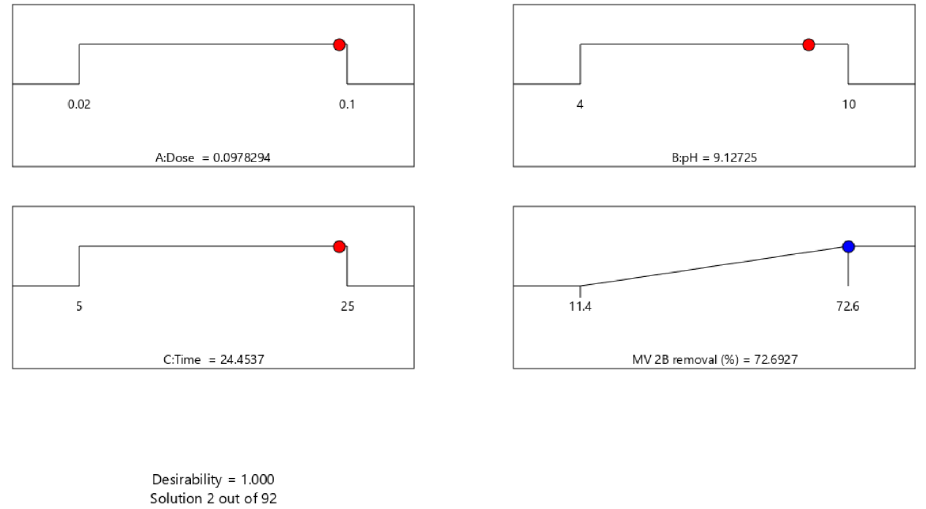
Figure 6. Desirability ramps for optimizing essential adsorption inputs for MV 2B removal (%) using MCAC.